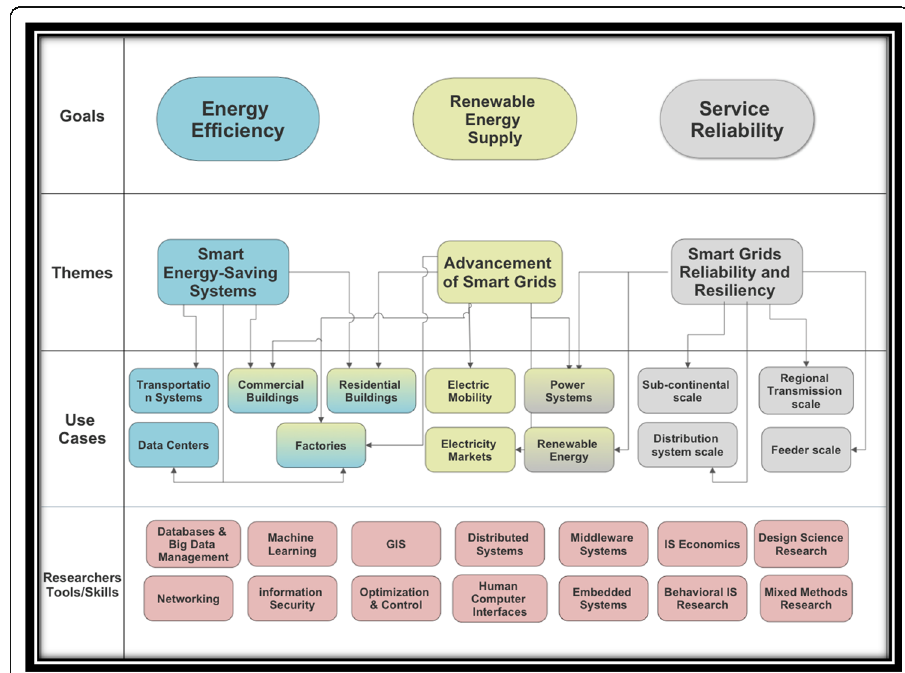
Fig. 1 Energy informatics enhanced research framework — Enriched with reliability